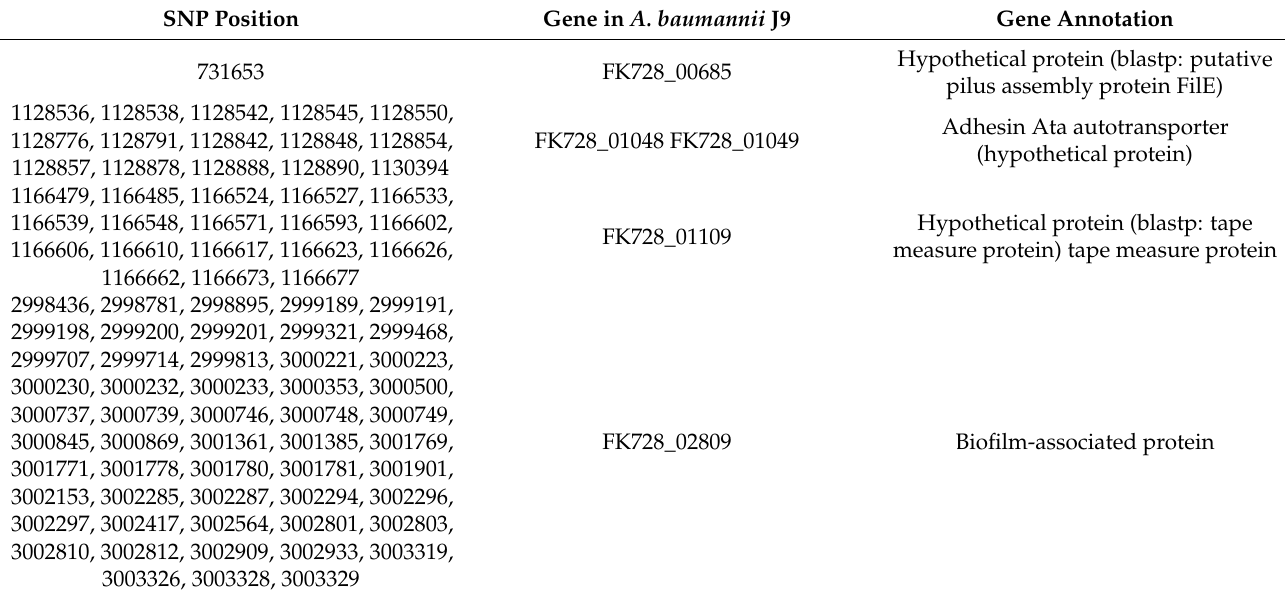
Table 2. Single nucleotide variation in the metagenomic strain using A. baumannii J9 as a reference. Ribosomal gene, tRNA genes, transposases, and prophage integrase A were excluded. SNP Position Gene in A. baumannii